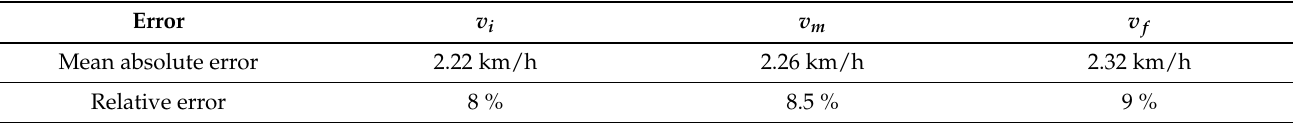
Figure 8. Comparison between constructed and measured vehicle speed trajectories for a road link. Table 4. Errors between modeled and measured speed trajectories for the validation case (Marseilles,